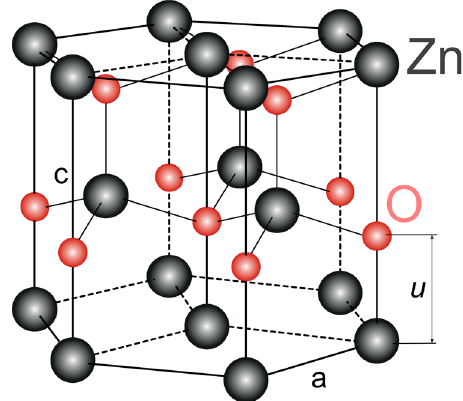
Figure 1: Axonometric hexagonal image of tripled ZnO conventional unit cell ( UC ) with enclosed labels ( horizontal coordinates of atoms in the fi fth layer coincide with those in the fi rst layer ) . Dashed lines correspond to the lines of adjacent UCs. The parameter u deter - mines the relative lengths of Zn – O